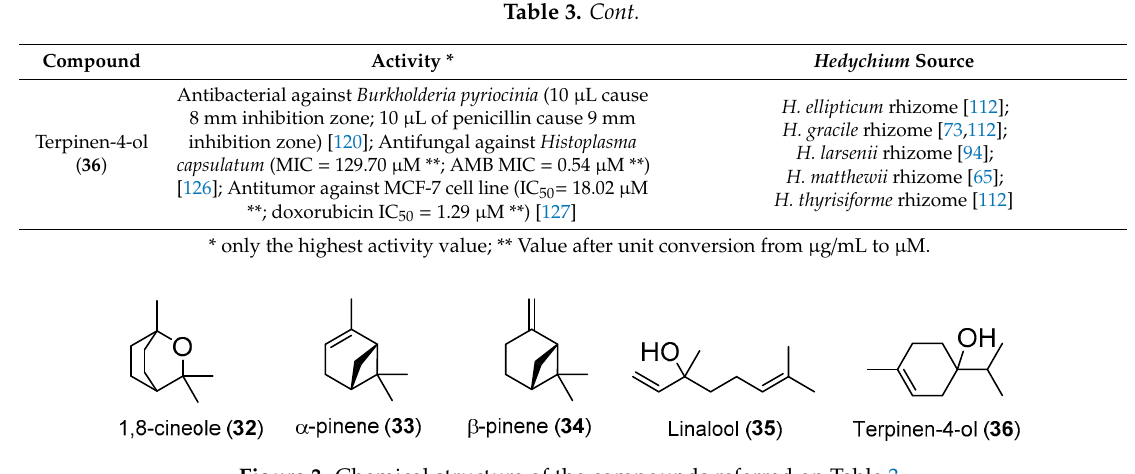
Figure 3. Chemical structure of the compounds referred on Table 3.